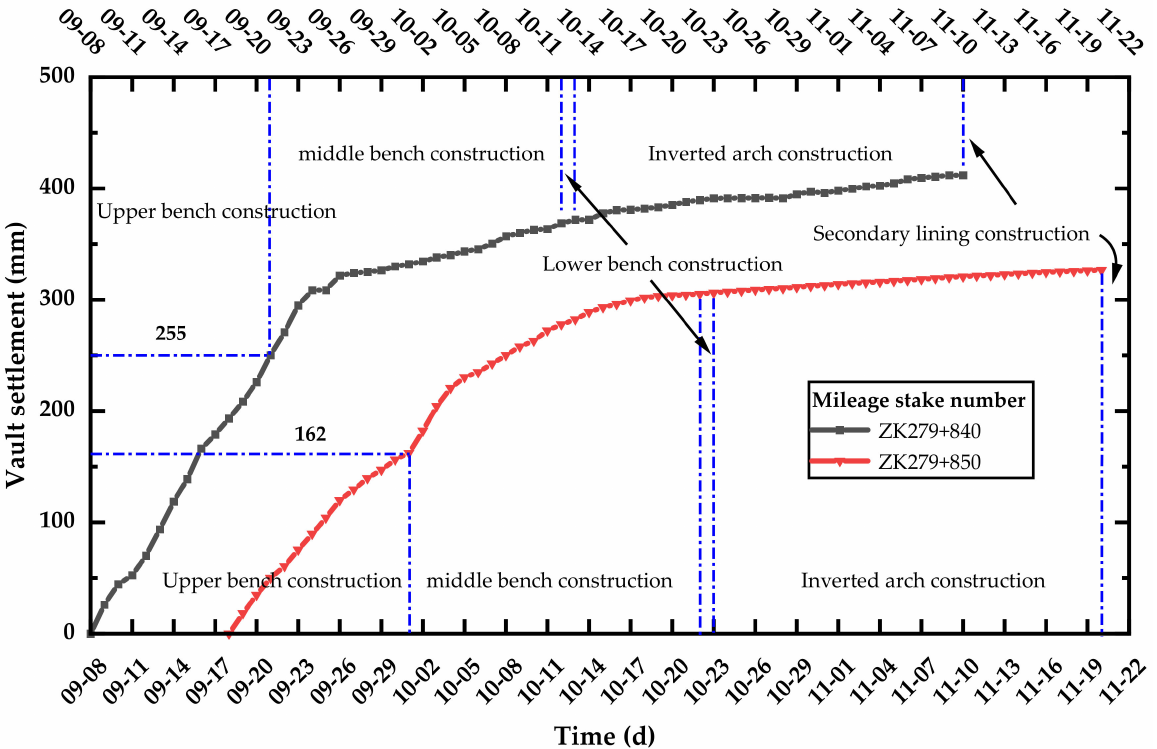
Figure 15. Vault settlement–time history